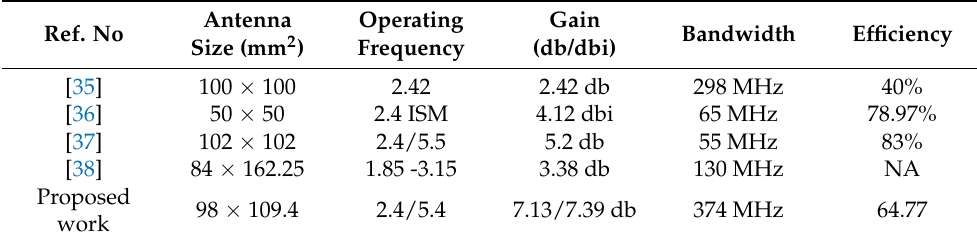
Table 9. Comparison